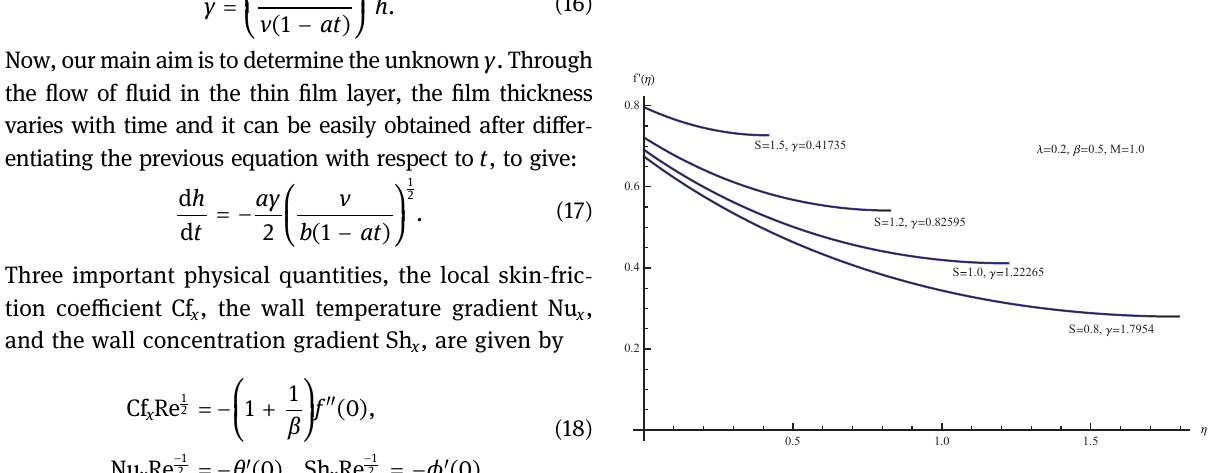
Figure 2: ( ) f η ′ for assorted quantities of S